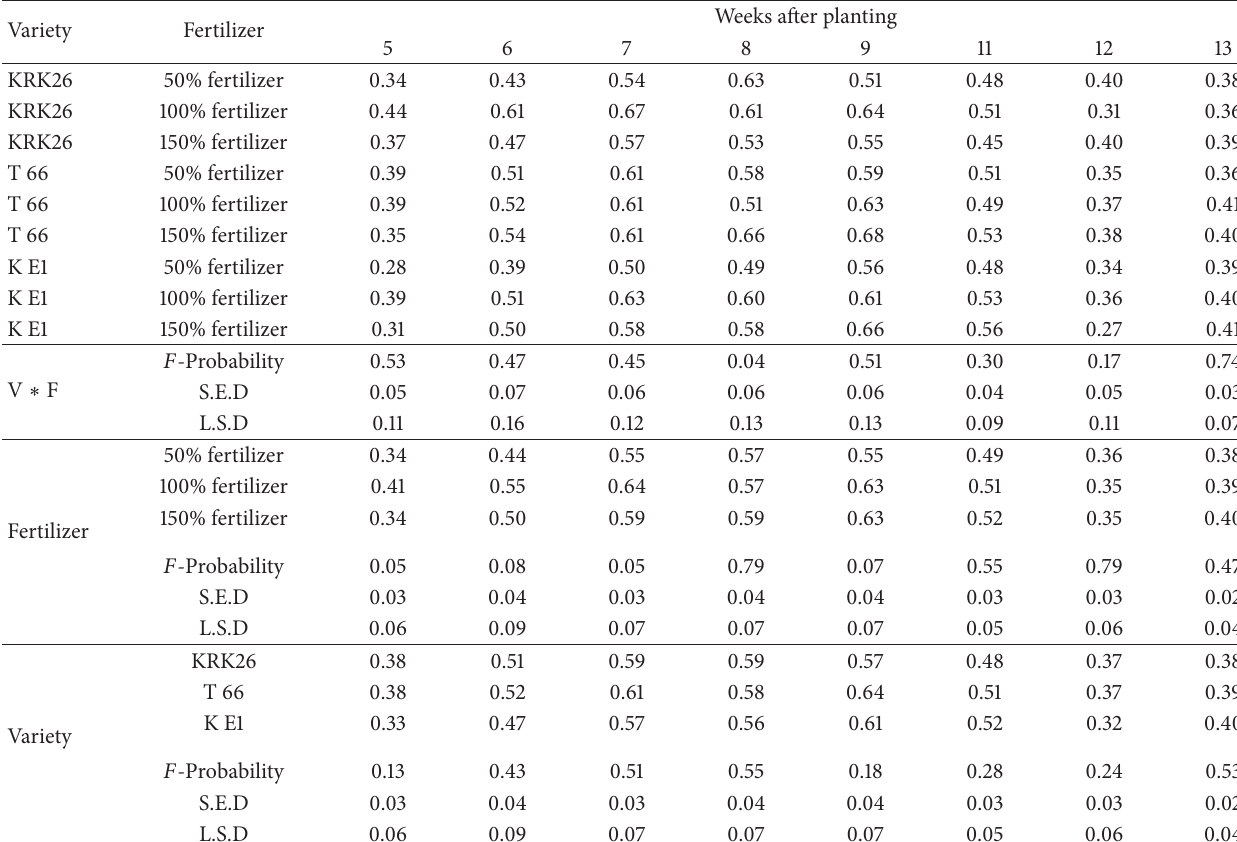
Table 6: The NDVI temporal profiles for the December 15 planted crop.